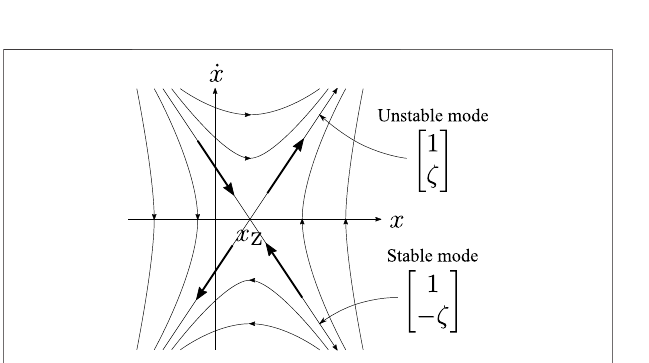
FIGURE 10 | phase portrait of the system Eq. 1 with x two eigenvalues ζ (unstable) and − ζ (stable) with symmetric asymptotic directions [ 1 ζ ] T and [ 1 − ζ ] T .